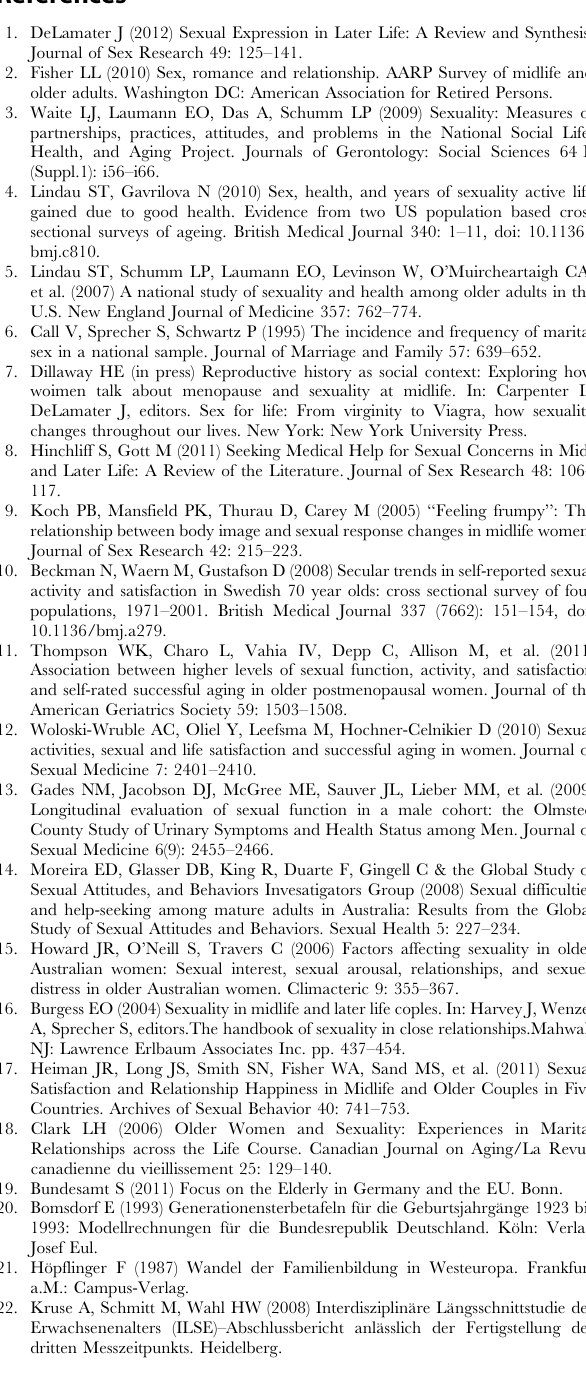
Table S1 Data sheet containing all variables